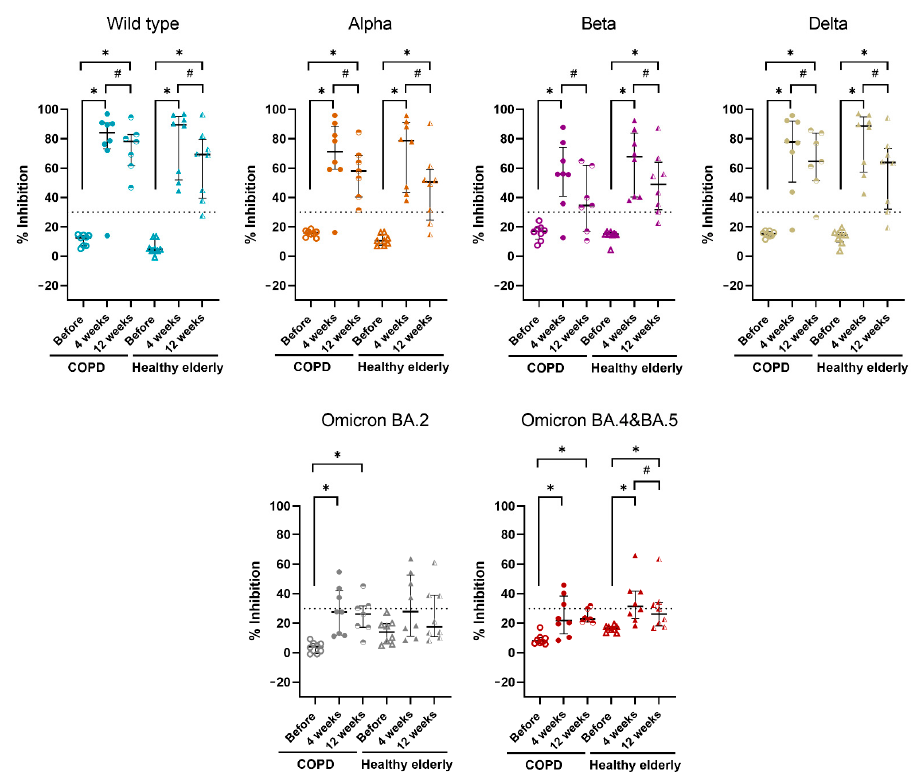
Figure 1. Neutralizing antibodies against SARS-CoV-2 wild-type, Alpha, Beta, Delta, Omicron BA.2, and Omicron BA.4 and BA.5 variants after receiving ChAdOx-1/ChAdOx-1 homologous vaccination. Note: Plasma was obtained from COPD ( n = 8 or 7) and healthy elderly ( n = 8) before and at 4 weeks or 12 weeks after the 2nd dose of ChAdOx-1/ChAdOx-1 homologous vaccine. The % inhibition of neutralizing antibodies against wild-type, Alpha, Beta, Delta and Omicron variants are shown. Dot plots exhibit as median with interquartile range which a dot represents each indi- vidual. The horizontal lines indicate 30% inhibition threshold level of neutralizing antibody. *, p -value < 0.05 compared to before receiving vaccines; #, p -value < 0.05 compared to 4 weeks after receiving vaccines using Wilcoxon signed-rank test. Table 2. Levels of % inhibition of neutralizing antibodies against the wild-type, Alpha, Beta, Delta, and Omicron variants of SARS-CoV-2 before and at 4 and 12 weeks after receiving ChA- dOx-1/ChAdOx-1 homologous vaccination.